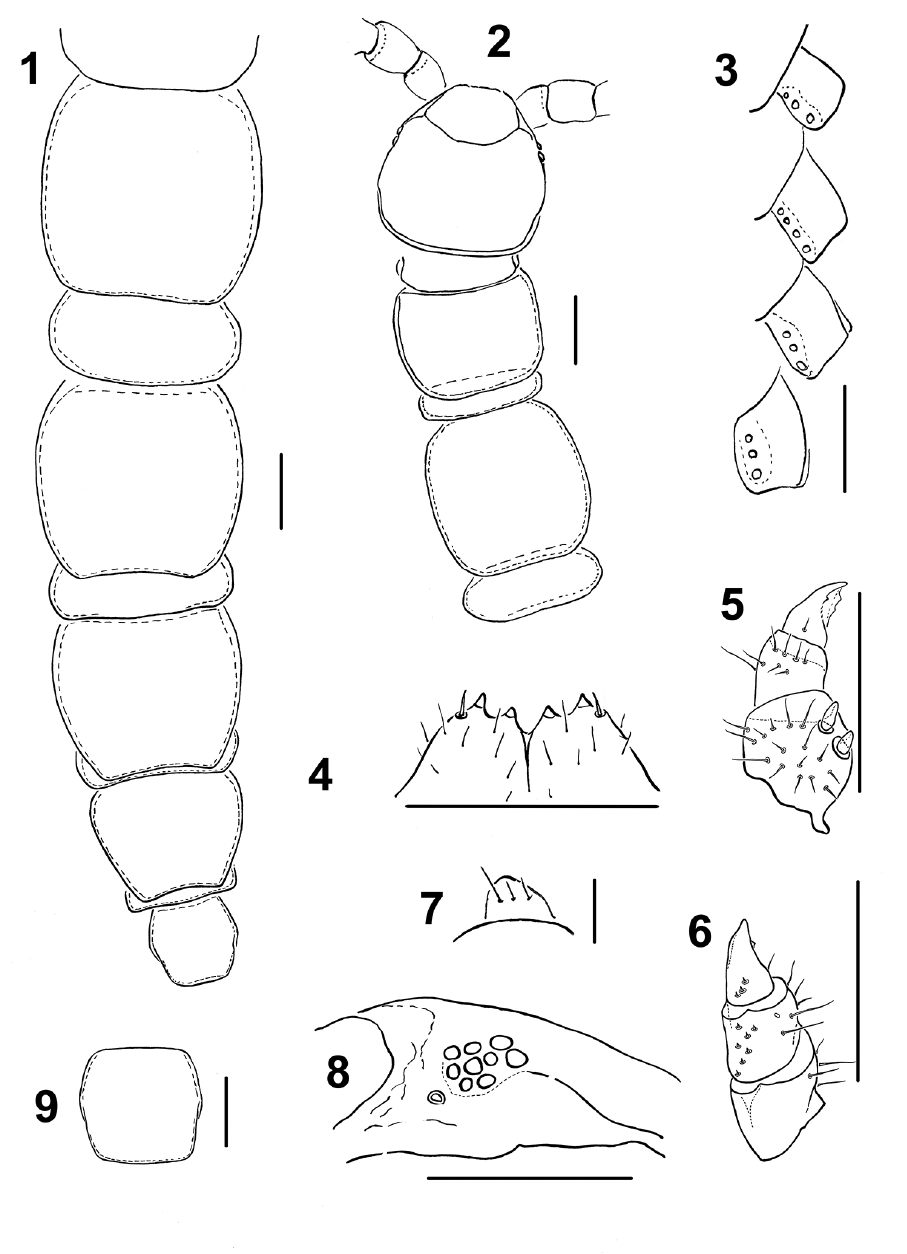
Figures 1–9. Lithobius ( Chinobius ) yuchernovi sp. n., paratypes. 1 male 8–16 tergites, dorsal view 2 male front body part, dorsal view 3 female coxal pores of legs 12–15, ventral view 4 male forcipular coxoster- nite, ventral view 5–6 female gonopod, ventral and dorsal view, respectively 7 male gonopod, ventral view 8 female ocelli and Tömösváry’s organ, lateral view 9 female intermediate tergite, dorsal view. Scale bars: 0.5 mm ( 1–6, 8, 9 ), 0.1 mm ( 7